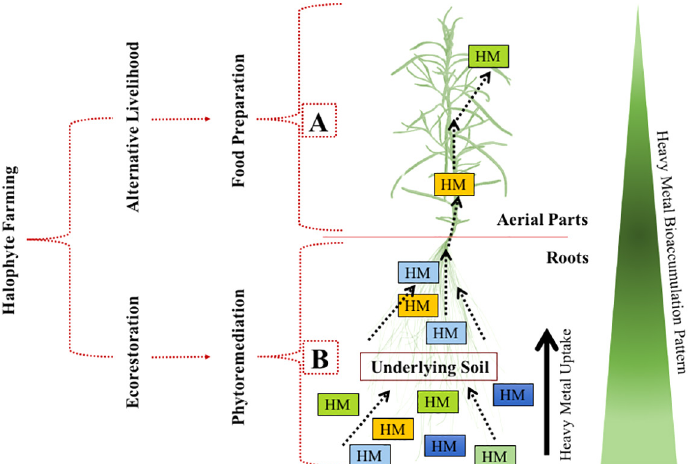
Figure 7. Proposed mechanism of phytoremediation of heavy metals (HMs) by the mangrove associate species of Indian Sundarbans and their application in ecorestoration and alternative livelihood generation through large-scale farming. A schematic diagram of a representative mangrove associate species shows enhanced HM enrichment in the below-ground biomass (i.e., roots) and reduced HM translocation to the above-ground biomass (i.e., shoots and leaves). The red dotted bracket “A” indicates the portion of the plant (i.e., aerial parts) that could be used for food preparation after farming of these halophytes since maximum metal enrichment is seen in the roots with the lowest metal translocation to leaves, followed by shoots in the present study. The red dotted bracket “B” indicates the portion of the plant (i.e., roots) that primarily assists in phytoremediation through the phytostabilization process. The black dotted arrows denote the direction of metal uptake/transfer. The base of the green-colored triangle denotes the highest HM concentration, while its apex indicates the lowest metal